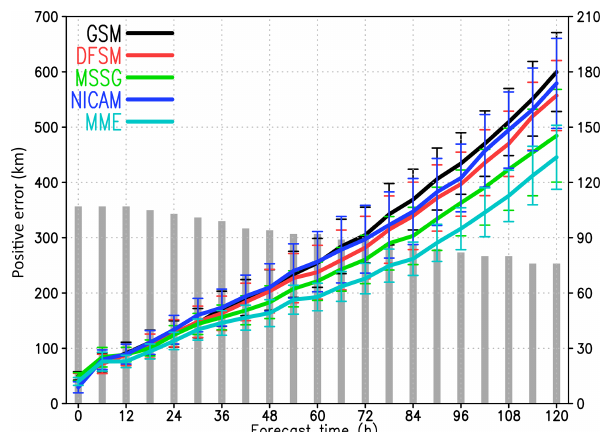
Figure 3. Errors in the track prediction for GSM, DFSM, MSSG, NICAM and MME (in the second stage). Each grey bar indicates the number of samples at each forecast time (right-vertical axis). Error bars indicate 95% confidence levels of the central pressure difference between the prediction and the RSMC Tokyo best-track data.